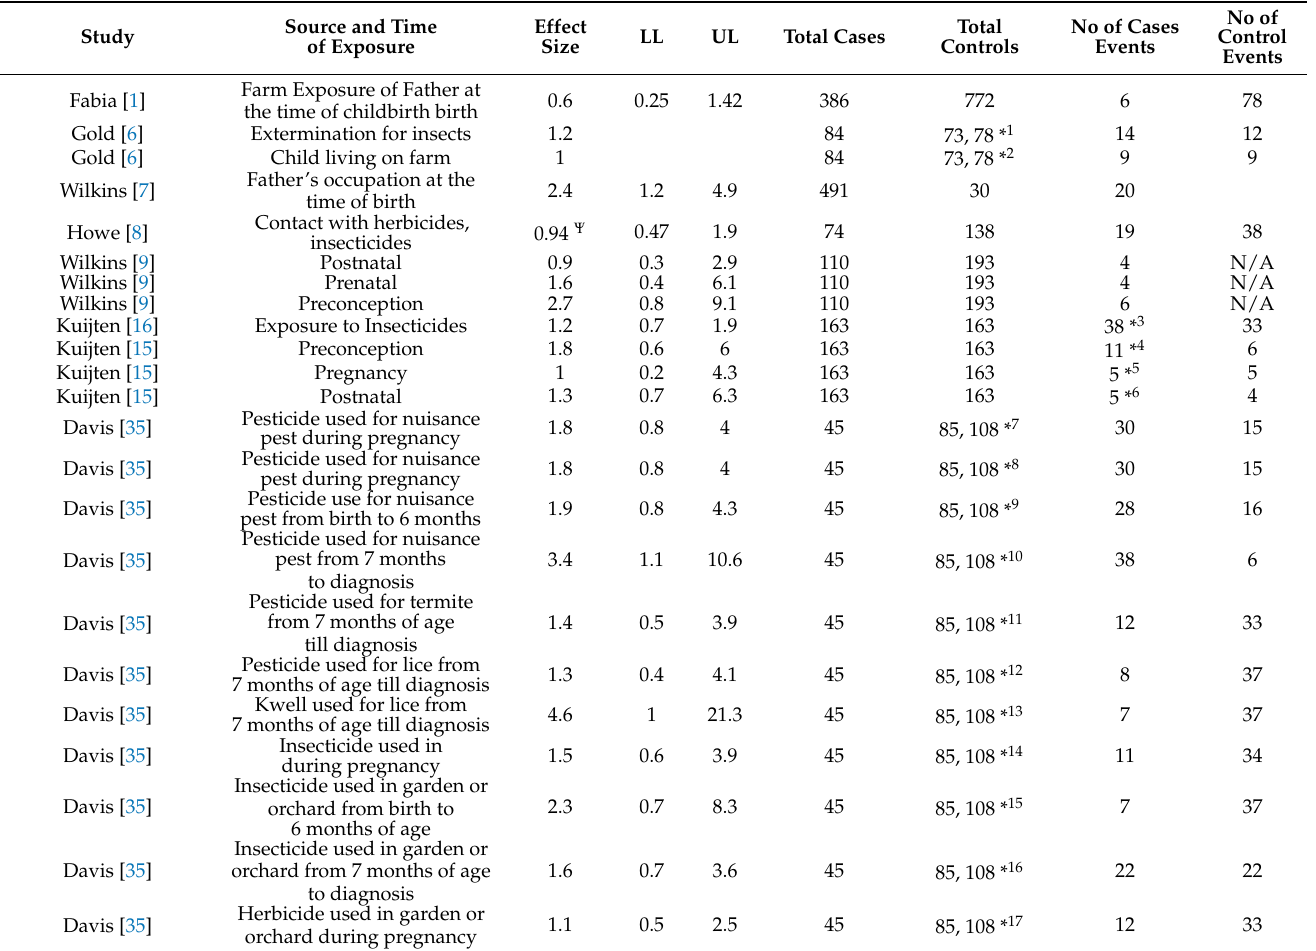
Table 1. Characteristics of studies included in the